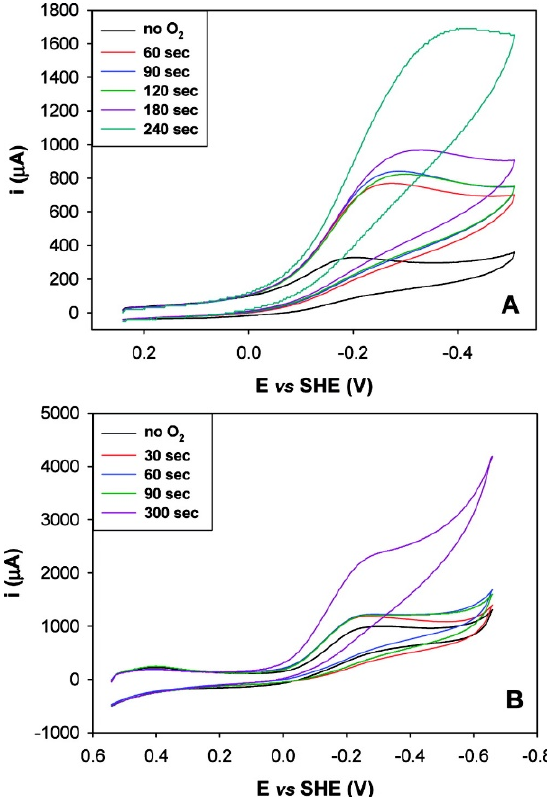
Figure 2. Cyclic voltammograms for the M80A/C102T mutant of yeast iso-1-cytochrome c immobilized on a polycrystalline gold electrode coated with a SAM of 1:1 MUA/MU at pH 5.2 ( A ) and 7 ( B ), recorded upon increasing exposure to air. For solution composition and other experimental conditions, the reader is referred to the original literature. Reprinted with permission from ref. [37]. Copyright 2008 American Chemical Society.